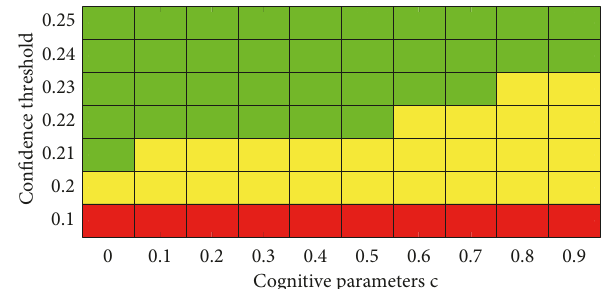
Figure 3: Steady state of a social system with different confidence thresholds and cognitive parameters ( 𝑐